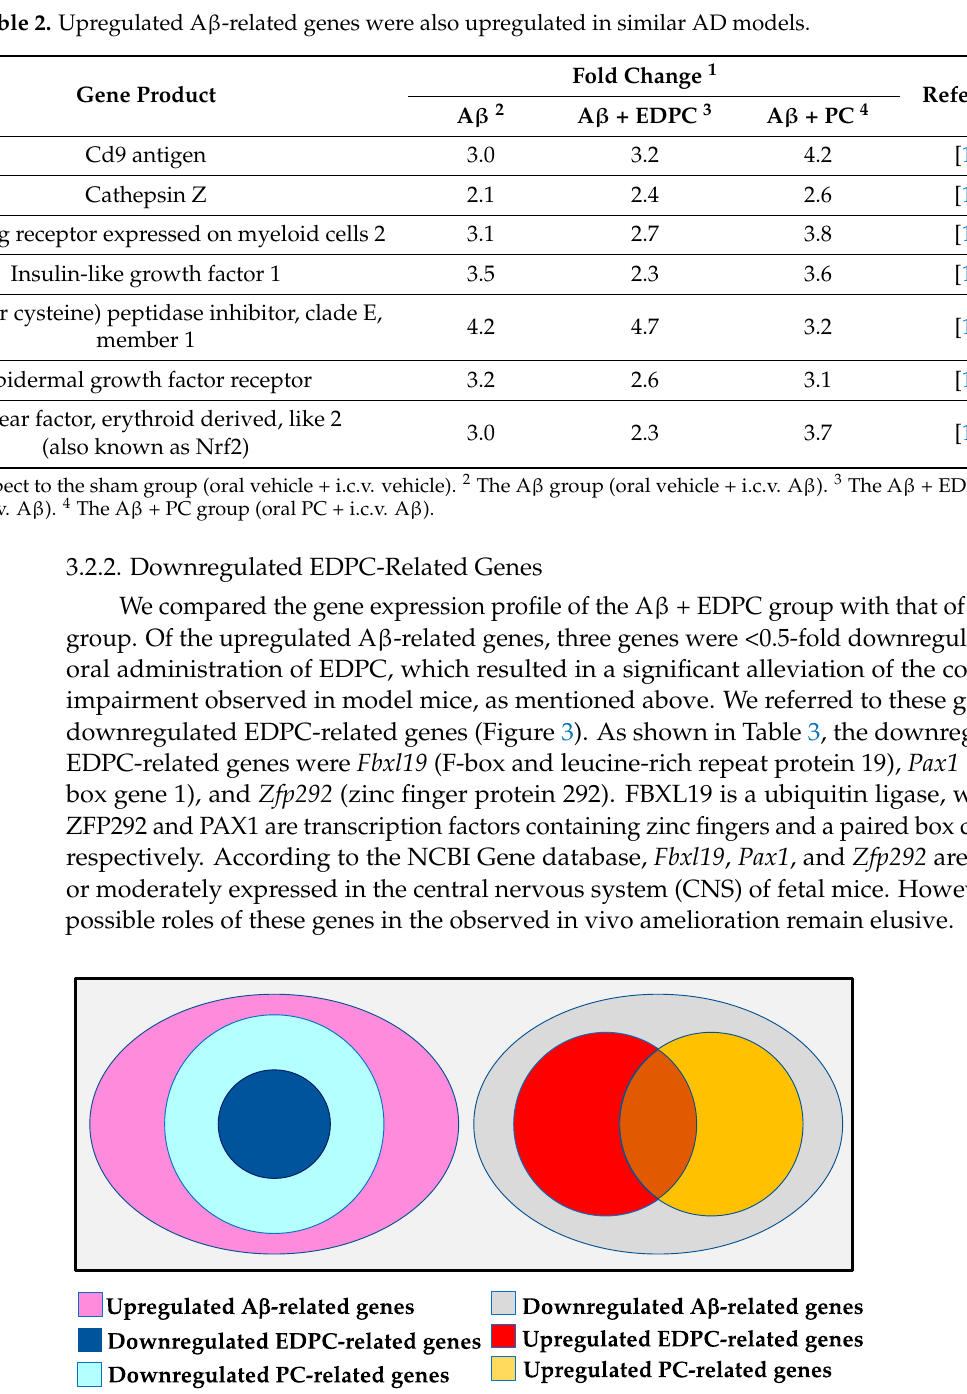
Figure 3. Relationship between A β -, EDPC-, and PC-related genes. All of the downregulated and some of the upregulated EDPC-related genes overlapped with PC-related genes. Areas are not drawn to scale.